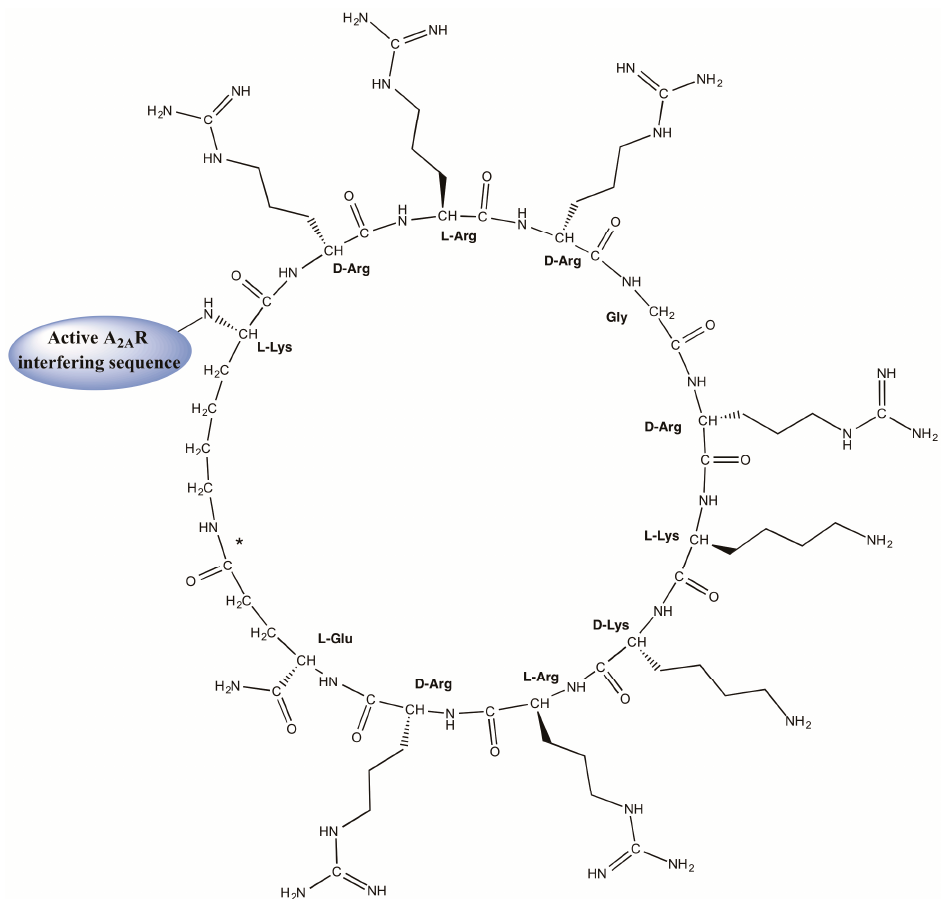
Figure 1. Structure of cyclic Tat-like construct KrRrGrKkRrE fused to A 2A R transmembrane (TM)-interfering sequences. The amide bond between the ε – amino group of the N-terminal Lys and the γ – carboxyl of C-terminal Glu is marked with an